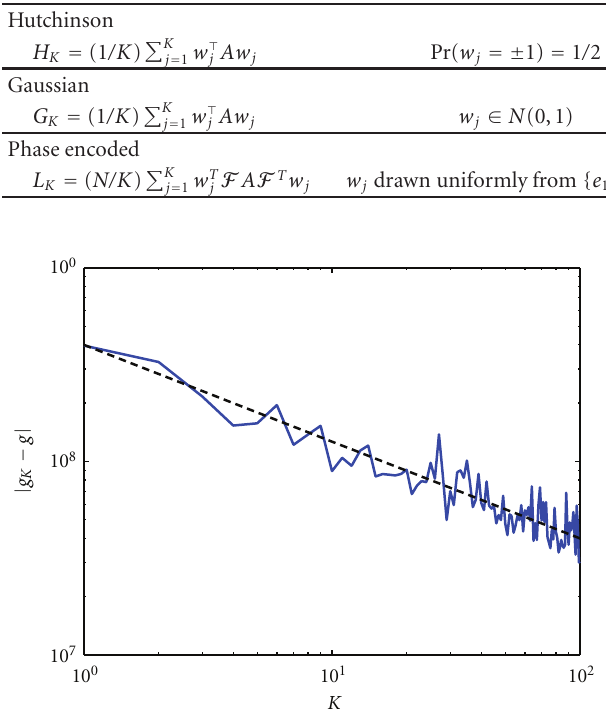
Figure 3: Error in the gradient as a function of the batch size K . As expected, the error goes down as 1 /